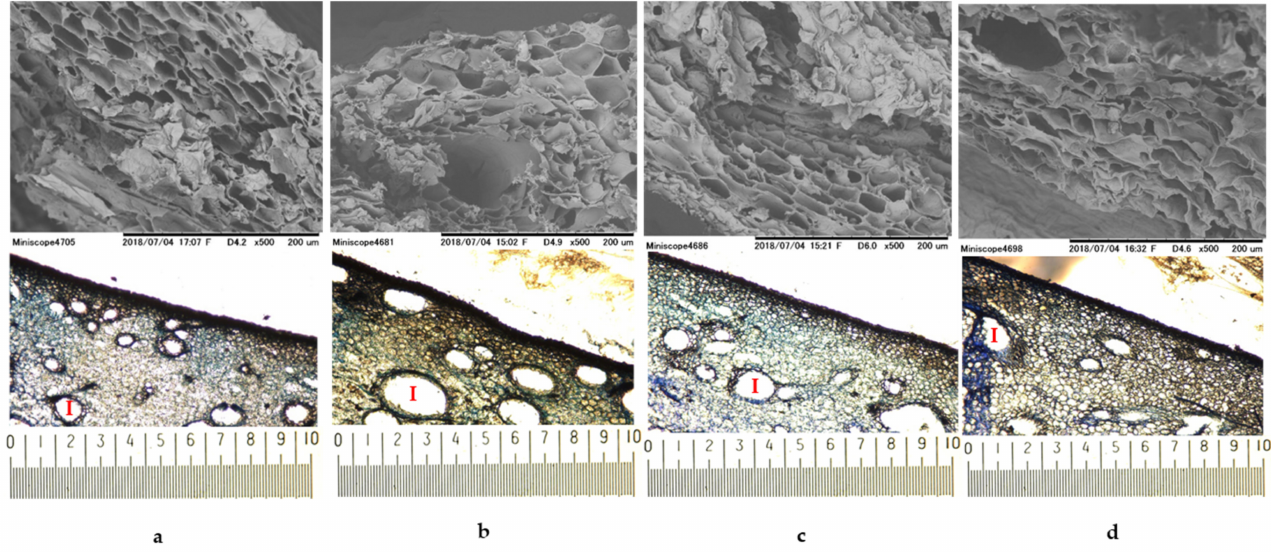
Figure 3. The SEM and LM images of mango peels var. ‘mahachanok’ ( a ), ‘chok anan’ ( b ), ‘nam dok mai’ ( c ), and ‘kaew’ ( d ). The images were viewed at × 500 and × 50 (0.1